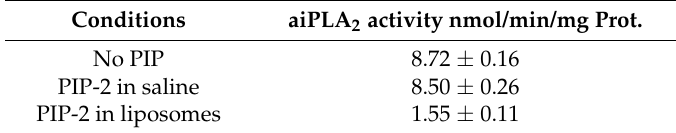
Table 5. Liposomes are required for inhibition of aiPLA 2 activity by PIP-2 in isolated mouse lungs.